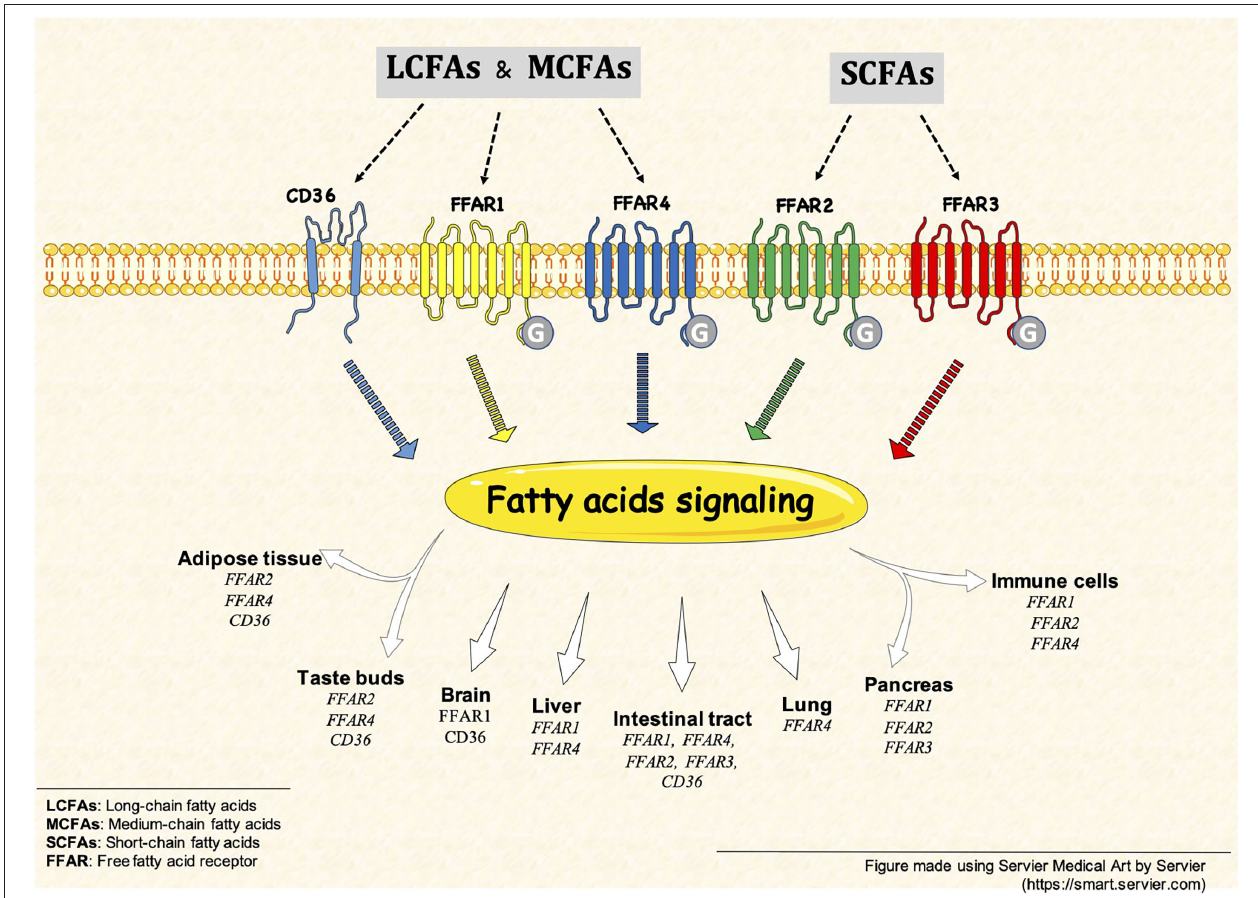
FIGURE 1 | Free fatty acid receptors (FFARs) and CD36. FFARs and CD36 are activated by different fatty acid, such as SCFAs, MCFAs and LCFAs. This fatty acid signaling is present in different tissues and cell types, some example are but not limited to: intestinal tract, brain, pancreas and immune